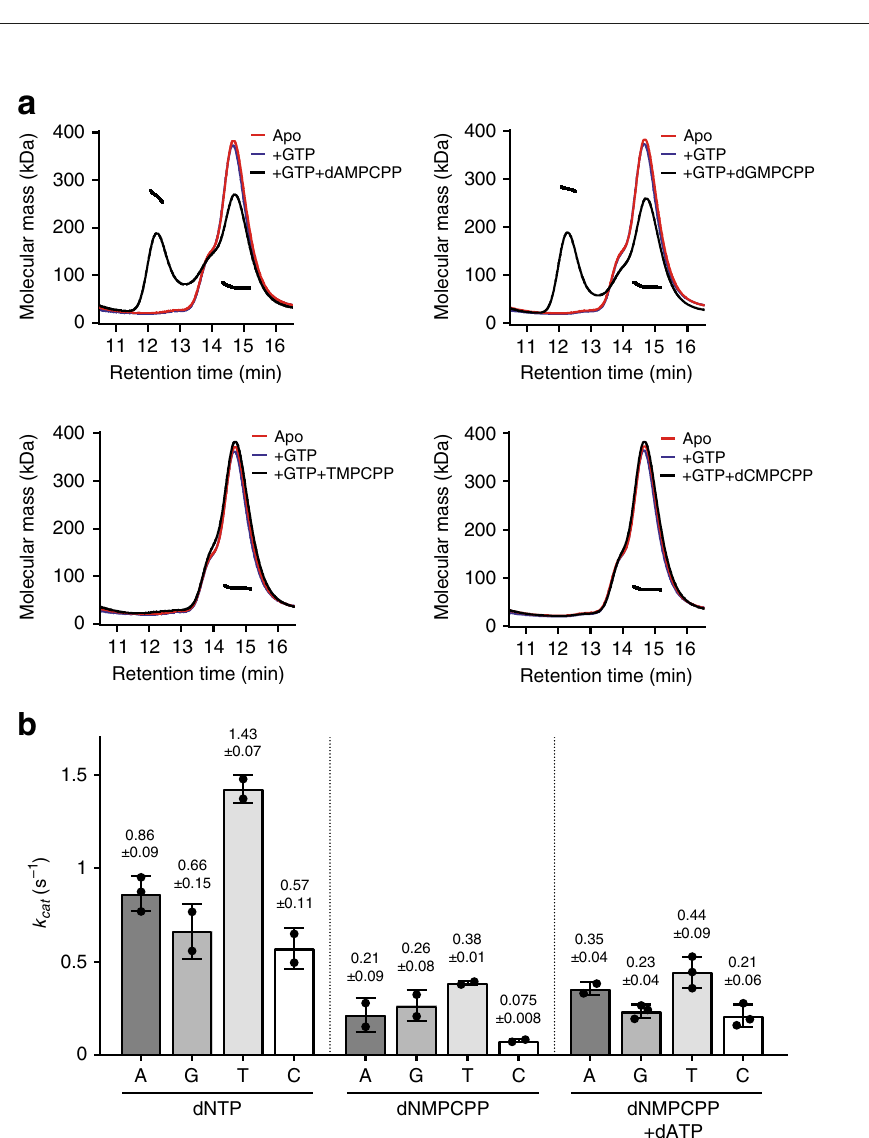
Fig. 1 SAMHD1 tetramerisation and catalytic inhibition by dNMPNPP nucleotides. a SEC-MALLS analysis of SAMHD1 monomer – dimer – tetramer equilibrium upon addition of dNMPNPP nucleotides. In each panel, the solid lines are the chromatograms from the output of the differential refractometer and the black scatter points are the weight-averaged molar masses determined at 1-s intervals throughout elution of chromatographic peaks, SAMHD1 monomer – dimers elute at 14 – 16 min, tetramers at 12 min. In each panel, the curves shown are: (red) apo-SAMHD1; (blue) SAMHD1 and 0.2 mM GTP; (cyan) SAMHD1 and 0.5 mM indicated dNMPNPP analogue; and (black) SAMHD1, 0.2 mM GTP and 0.5 mM indicated dNMPNPP analogue. For dGMPNPP, which can induce tetramer formation in the absence of GTP, only the chromatograms for the apo (red) and after addition of dGMPNPP (cyan) are shown. b Steady-state kinetic analysis of GTP-stimulated hydrolysis of dATP and dAMPNPP by SAMHD1, measured using the MDCC-PBP fl orescence- based coupled SAMHD1-Ppx assay. The dependence of the rate on substrate concentration is plotted for (black) dATP and (cyan) dAMPNPP. For the dATP reaction the solid line is the best fi t to the data using the Michaelis – Menten expression, that gives values for the derived constants K M and k cat of 44 ± 3 µ M and 0.4 ± 0.01 s − 1 , respectively. Error bars represent the standard error of the mean (s.e.m.) of three independent measurements. c Determination of dNMPNPP inhibition constants ( K i ) using the fl orescence-based coupled assay. Plots show the dependence of the SAMHD1 hydrolysis rate of 0.1, 0.3 and 1 mM TTP on the concentration of each dNMPNPP. Reported K i values (inset and Supplementary Table 1) were derived from global fi tting of each 3-concentration dataset. Error bars represent the s.e.m. of three independent measurements. Source data for b and c are provided in the Source Data fi le.